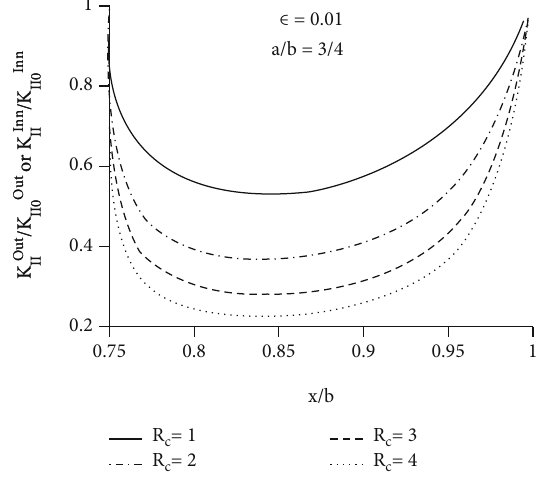
Inn / K 0Inn or K II II